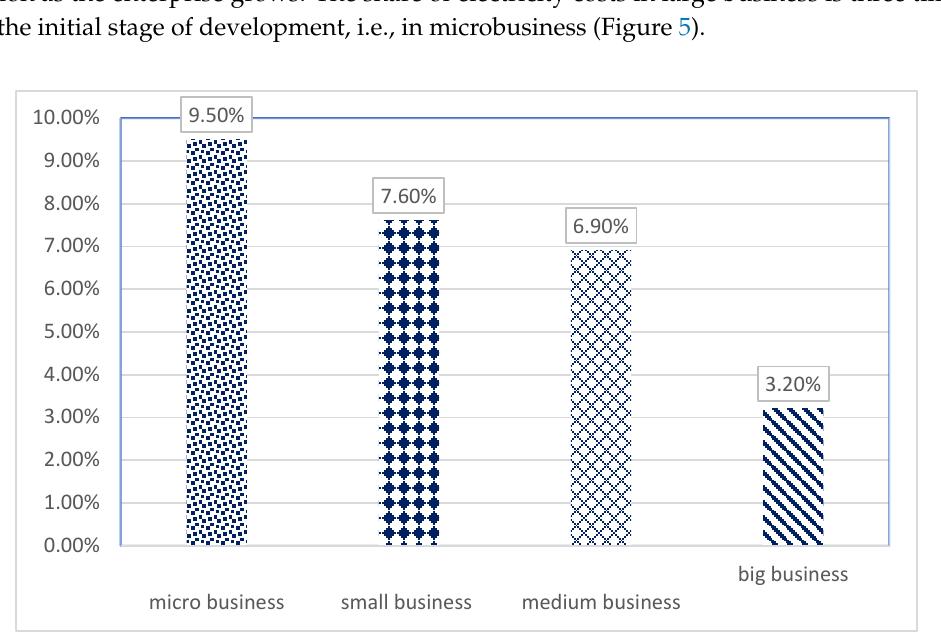
Figure 5. The portion of electricity costs for a business of various sizes. Source: personal elaboration.